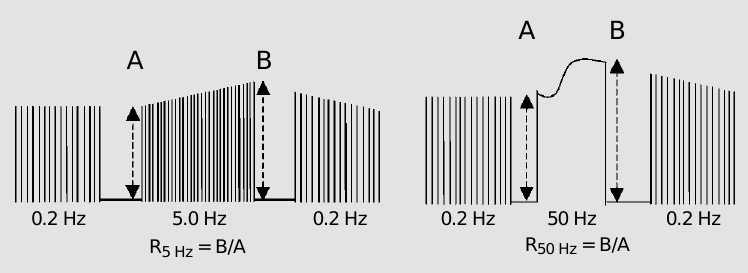
Figure 1. Diagram representation of muscular contraction induced by different frequencies of stimulation applied indirectly to the rat diaphragm. Drug effects are calculated as the ratio (R) between the tension at the end (B) and the maximal tension at the start (A) (R = B/A) of the response recorded at different frequencies of stimulation (5 and 50 Hz). The maximal tetanic tension is 15 g at 5 Hz and 22 g at 50 Hz. The sensitivity of the recording system at 50 Hz is lower than at 5 Hz and the latter lower than at 0.2